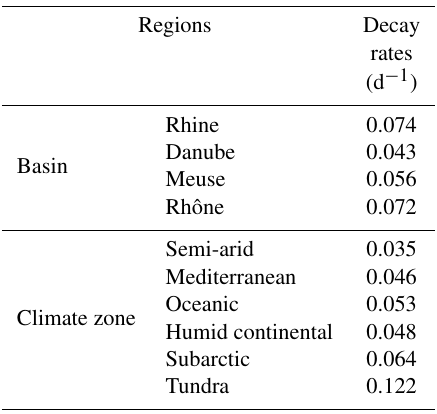
Table 2. Estimated river DOC decay rates applied in ORCHILEAK. Values are reported for four large river basin and for the six domi- nant climate